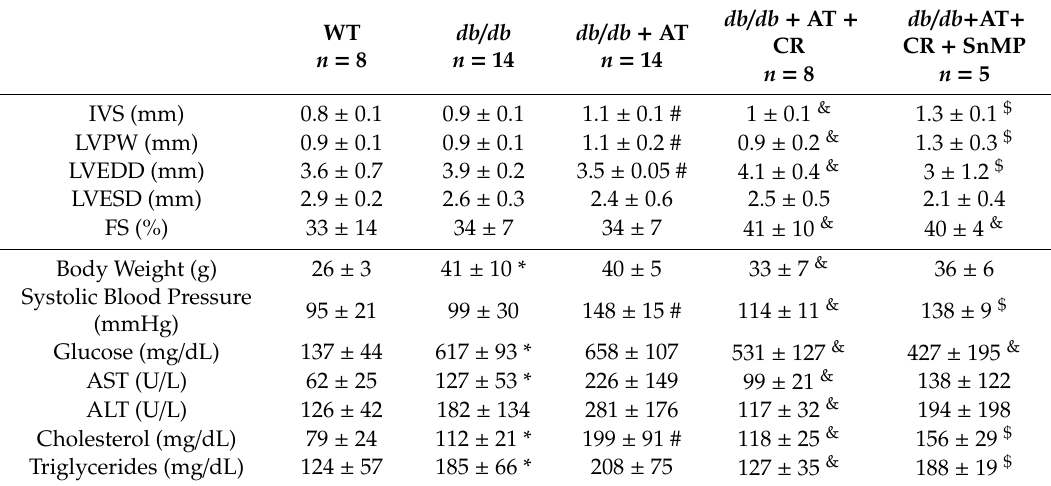
Figure 1. Cardiac heme oxygenase-1 (HO-1) proteins levels: caloric restriction (CR) alleviates oxidative stress through the activation of HO-1. HO-1 was reduced after angiotensin II (AT) treatment in cardiac tissue both in wild-type (WT) and diabetic mice compared to non-treated WT mice ( p = 0.001), but was elevated after CR. n = 4 in each group, * p < 0.05 vs. WT, & p < 0.05 vs. db / db + AT. Values represent mean ± SD. Table 1. The e ff ect of CR on LV dimension and biochemistry.